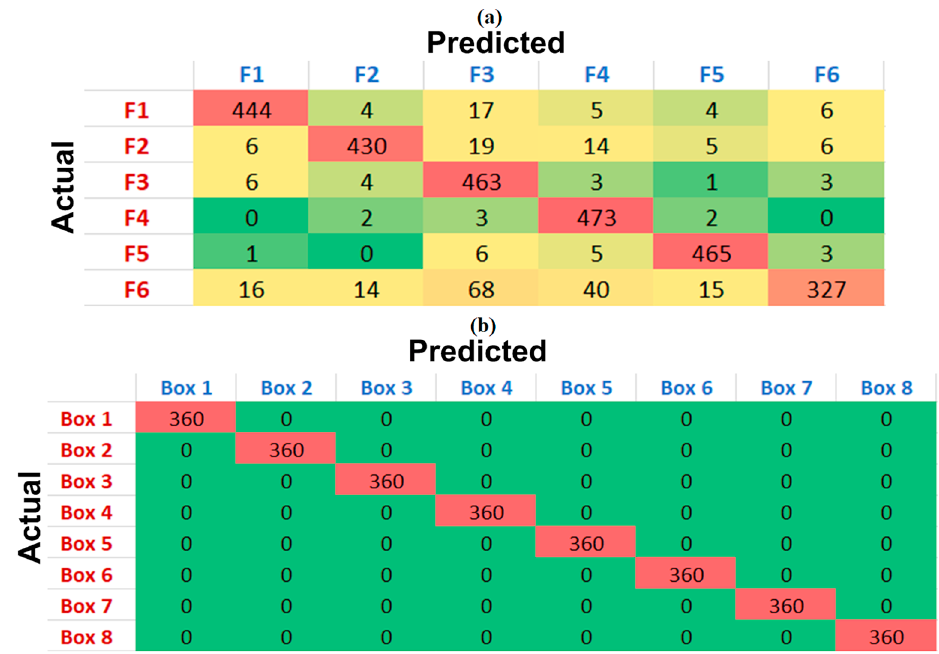
Figure 3. Confusion matrices. ( a ) SSVEP predictions. ( b ) Eye tracking predictions.